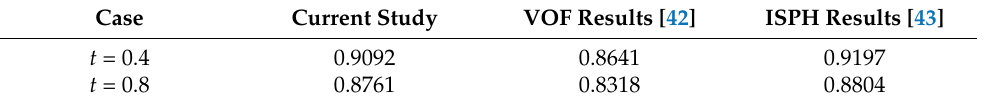
Figure 11. Comparison of the experimental and numerical (from the models of current study and other numerical studies) slope configurations at different times: ( a ) t = 0.4 s; ( b ) t = 0.8 s. Table 4. Correlation coefficients between the experimental and numerical results on the water